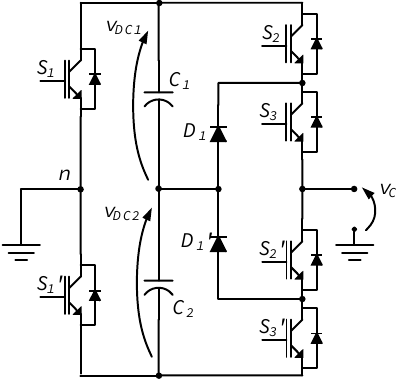
Figure 1. Topology of the 5-level converter used in the Shunt Active Power Filter (SAPF). Table 1. Voltage levels that the 5-level converter can assume during the positive and negative half-cycles. Voltage